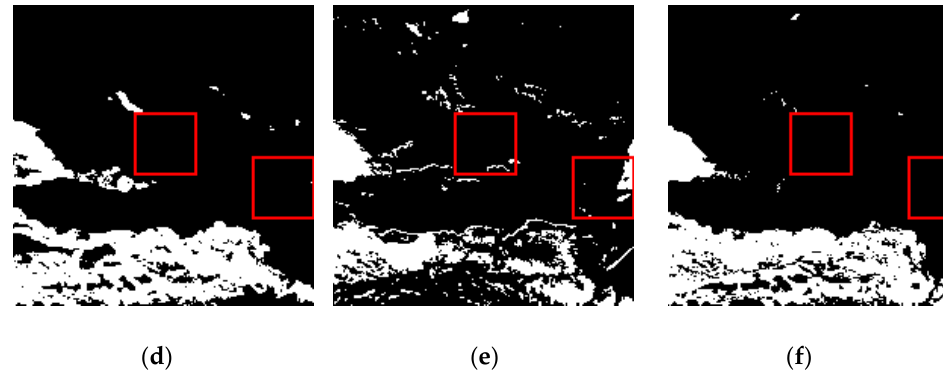
Figure 13. The enlarged subset of results. ( a ) Visible image; ( b ) Ground truth; ( c ) NSMC result; ( d ) NSMC-RF result; ( e ) Ensemble threshold-RF result; ( f ) Proposed RF result.